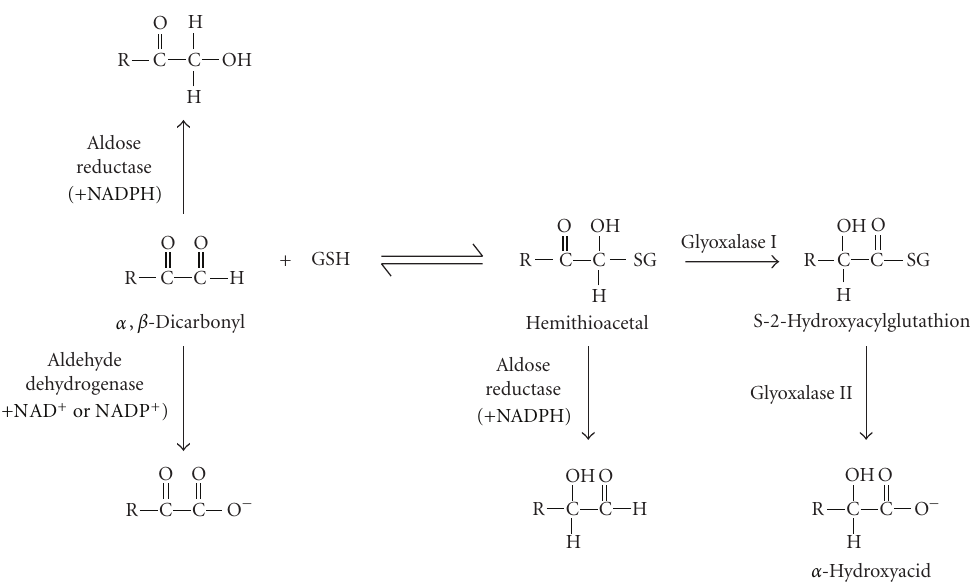
Figure 4: Physiological defences against α , β -dicarbonyl precursors of glycation. α , β -dicarbonyls like methylglyoxal (R:CH 3 ) and glyoxal (R:H) can be removed by aldose reductase-catalysed reduction to the corresponding alcohol or by oxidation to pyruvate and glycolate. respectively, catalysed by aldehyde dehydrogenase. Reactive α , β -dicarbonyls may also combine reversibly with reduced glutathione to form a hemithioacetal which can then be reduced by aldose reductases, forming lactaldehyde and glycoaldehyde from methylglyoxal and glyoxal, respectively. Alternatively, the hemithioacetal may undergo a two-step conversion to an α -hydroxyacid, catalysed by glyoxalase I and glyoxalase II. The glyoxalase enzyme system represents the major pathway by which methylglyoxal is